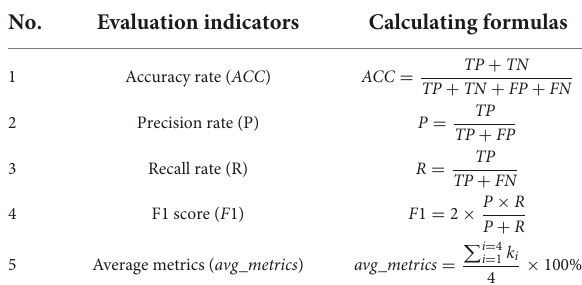
our improved model and other contrasting models.